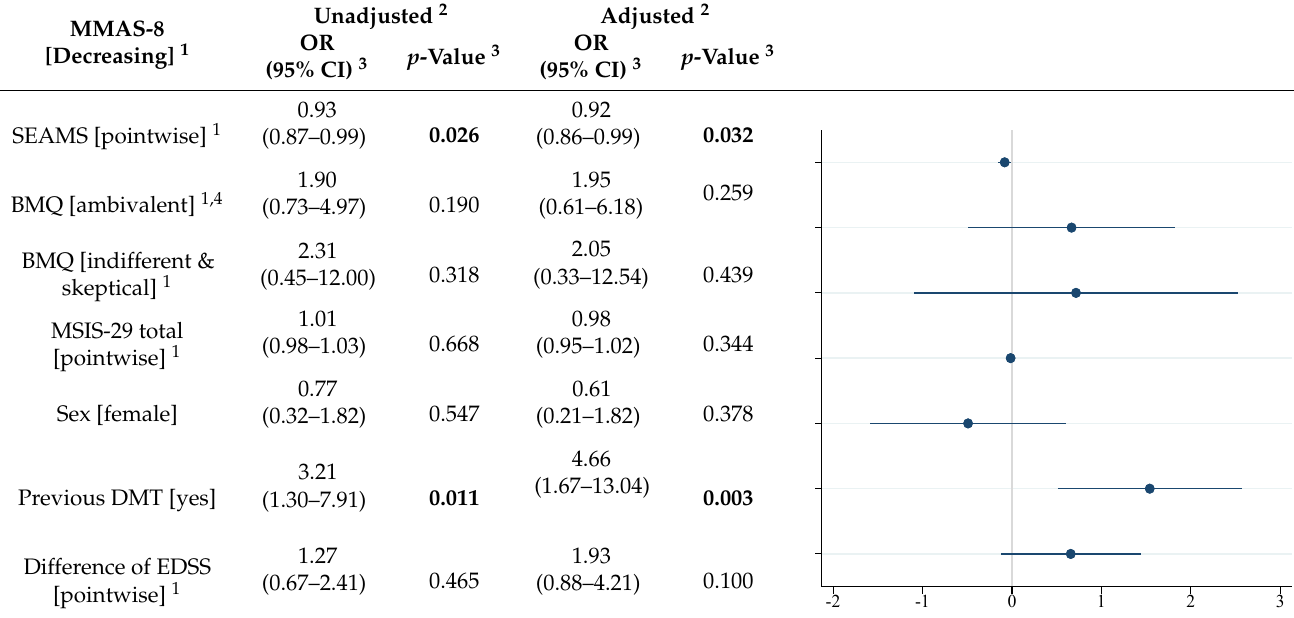
Table 2. Ordinal logistic regression models for the prediction of adherence category (MMAS-8; low, medium, and high) (N = 82). The pseudo-R 2 of the final multivariate model was 11.13%, which suggested that the concept of adherence was influenced by other important factors that were not measured in our setting.